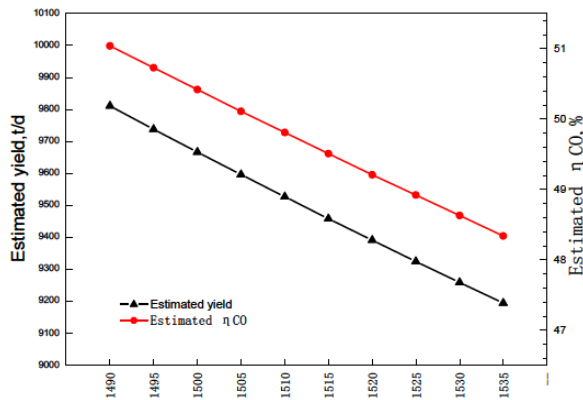
Figure 3: Estimated yield and η CO at different temperature.